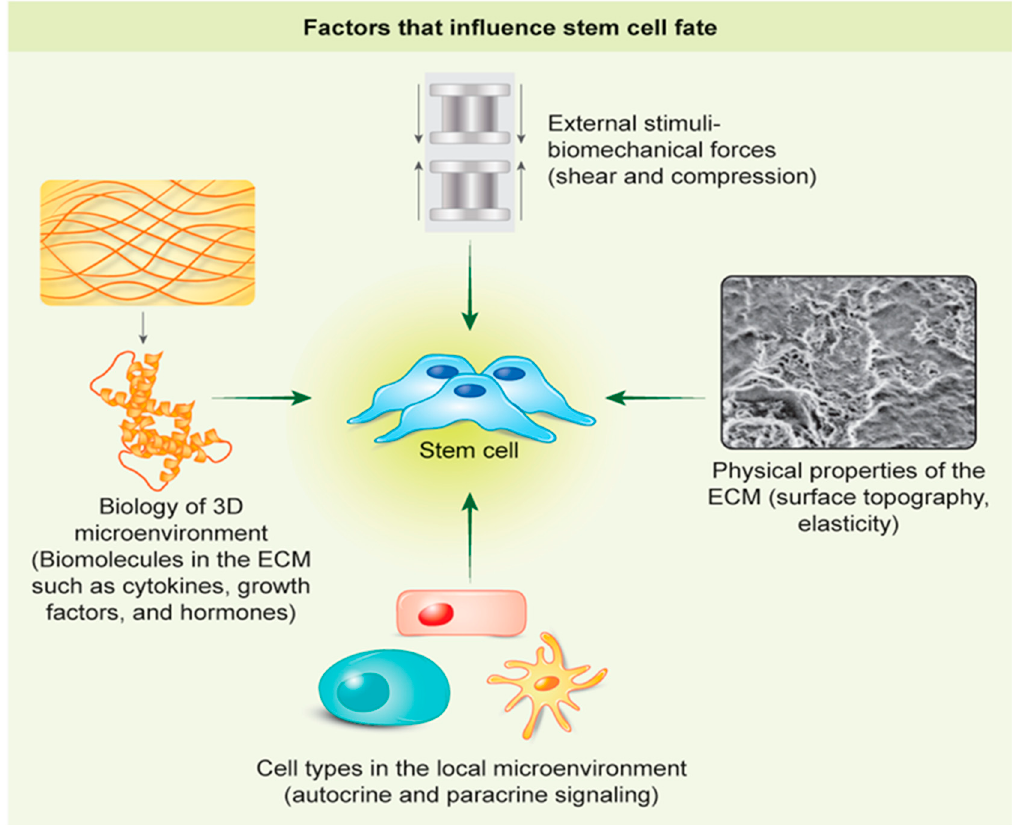
Figure 2. Factors that influence stem cell behavior. There are many influences on stem cells within the local microenvironment that controls or directs stem cell behavior including the extracellular matrix, local signaling agents, mechanical forces, and neighboring cells.